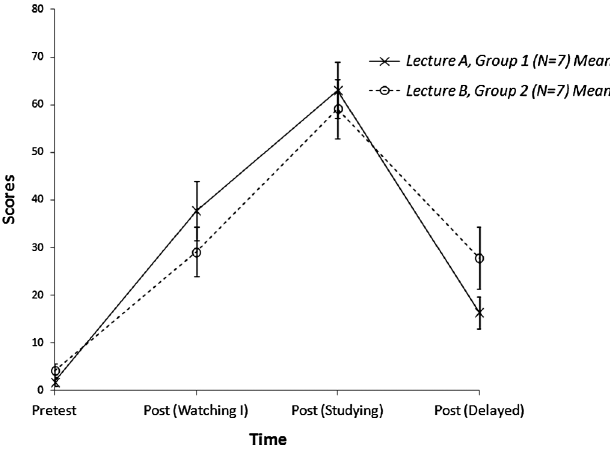
FIG. 2. The average content test scores of both lectures versus